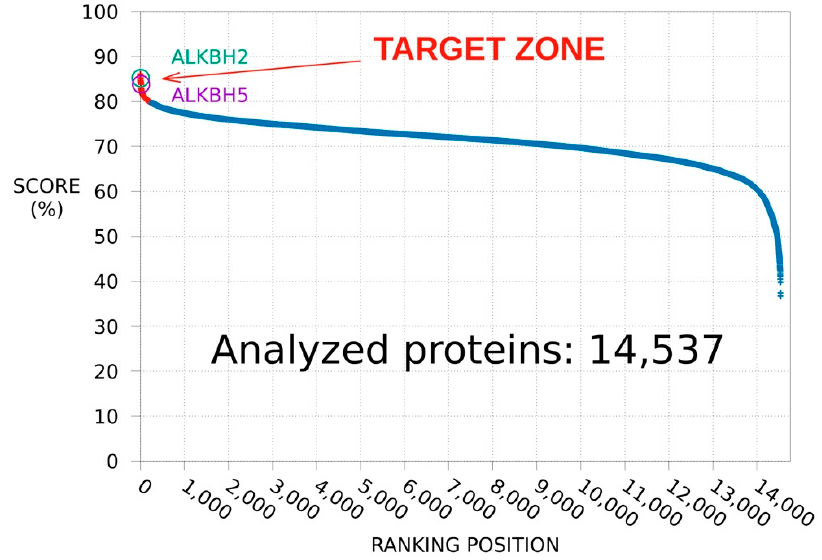
Figure 1. SPILLO-PBSS screening and ranking of the available human structural proteome—Plot resulting from the in silico screening and ranking carried out by SPILLO-PBSS on the available human structural proteome (14,537 protein structures retrieved from the RCSB Protein Data Bank [https://www.rcsb.org/] (last access 2 January 2022) in September 2017, excluding 100% sequence identity redundancies). ALKBH2 and ALKBH5 enzymes were found in the “Target zone” (in red, defined as the set of points that are on the left side of the point of maximum upward concavity of the curve) among the top-20 potential targets of MV1035.